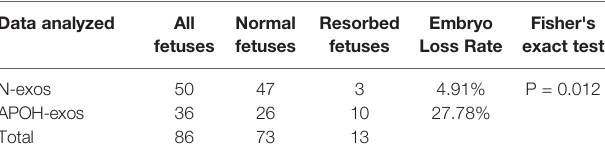
TABLE 3 | Embryo loss rate of Apolipoprotein H-exosome (APOH-exos) and control (N)-exos immunized mice (P = 0.012). Data analyzed All Normal Resorbed fetuses fetuses